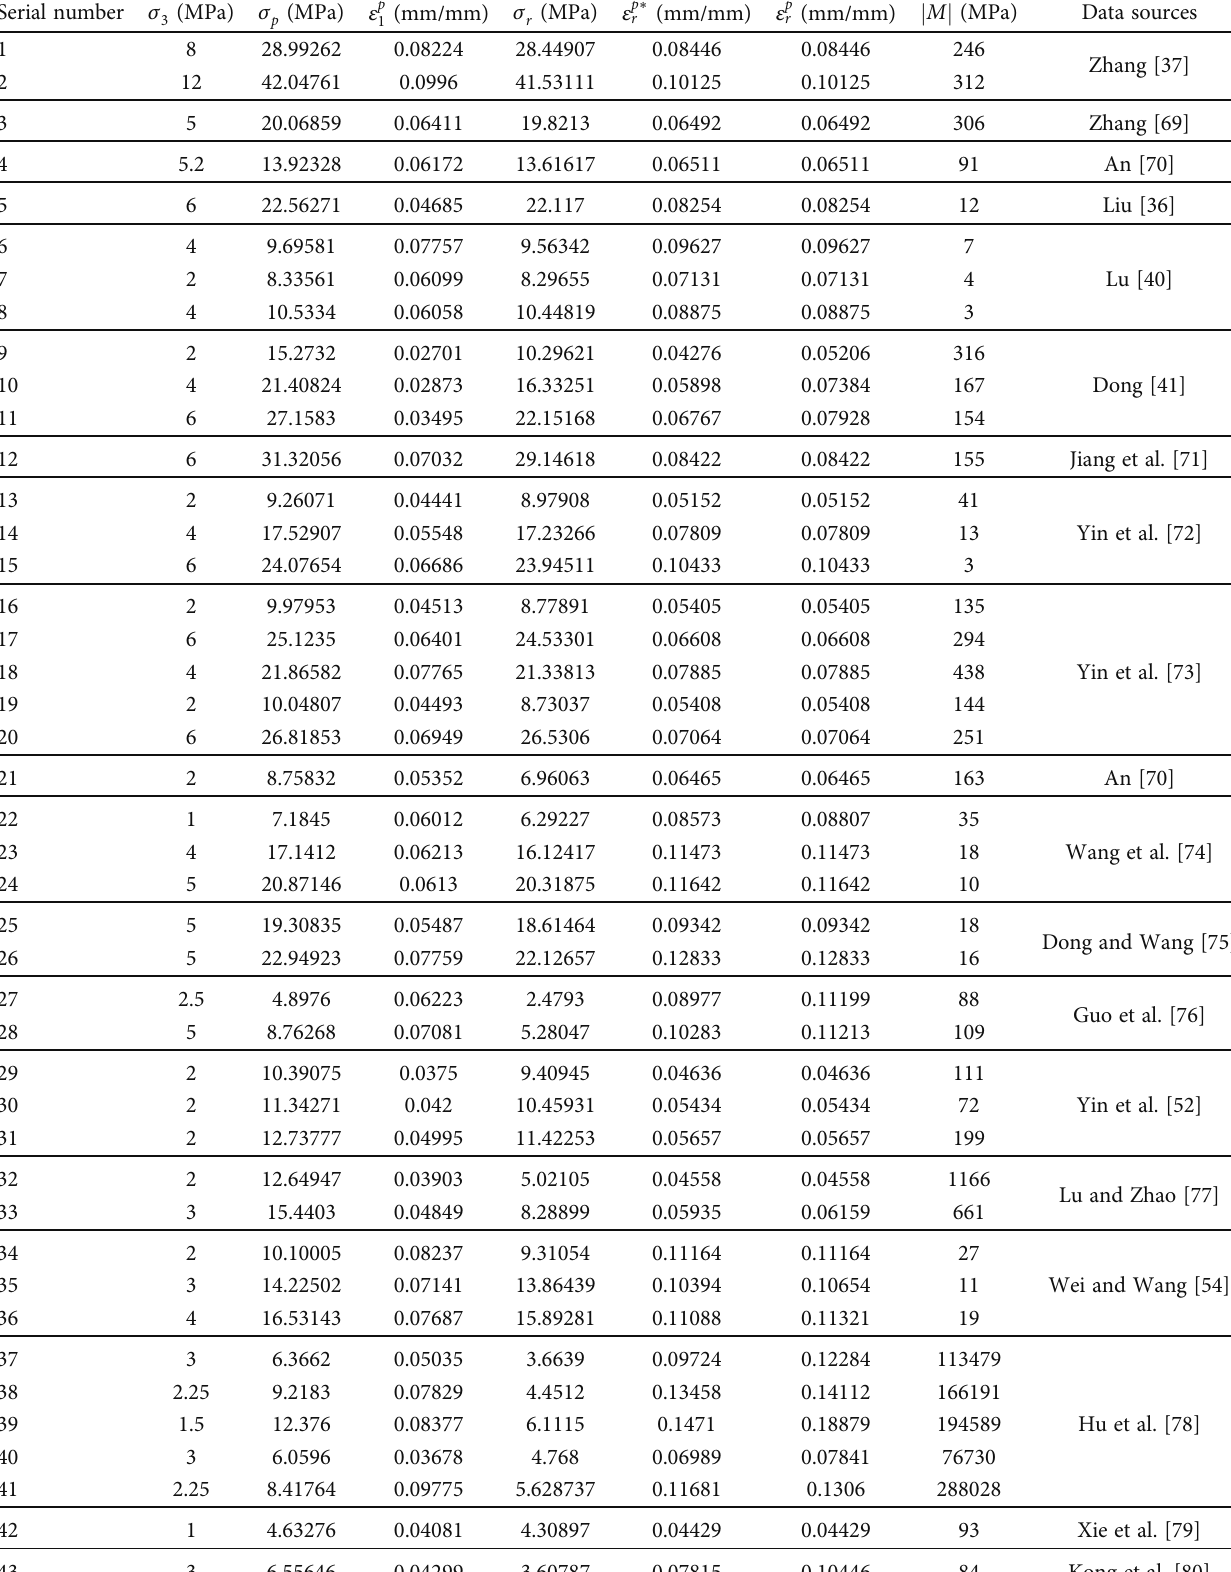
Table 3: Mechanical parameter statistics of complete stress-strain curves of briquette composed of soft coal during the triaxial